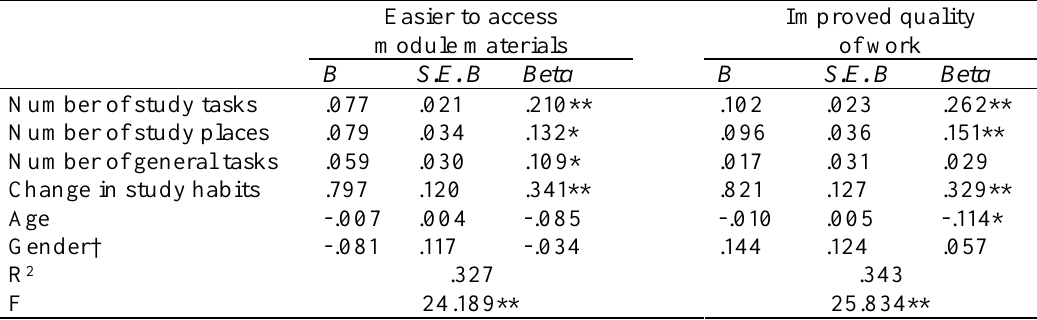
Summary of Regression Analysis